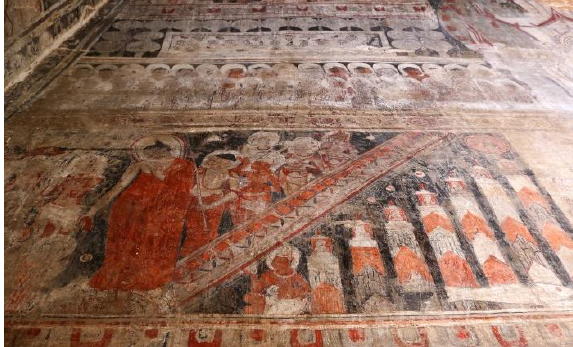
Figure 4 . Example of interior mural painting, Loka-hteik-pan. Source: Davide Mezzino. The main purpose of these artworks was most likely